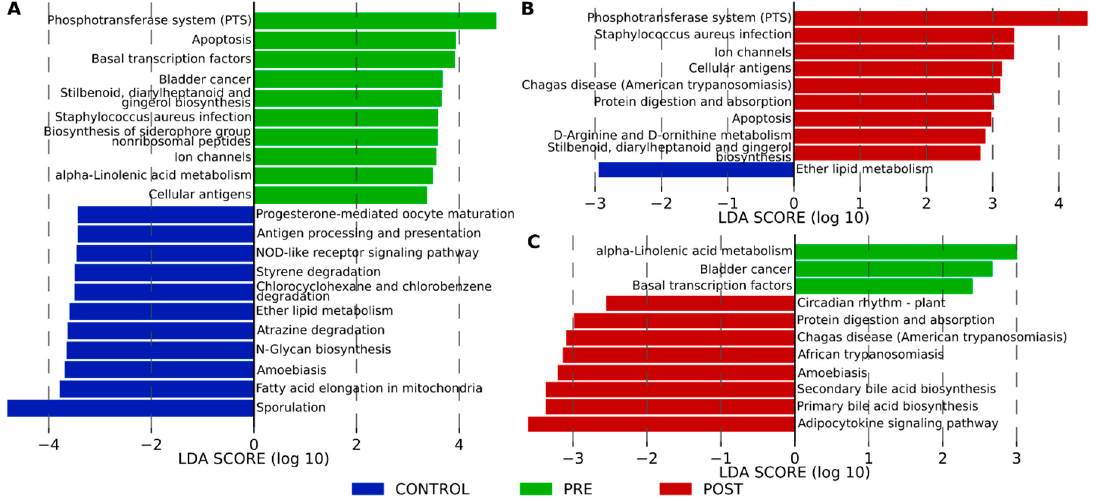
Figure 7. Functional divergence between the fecal microbiota of healthy controls and patients with CD pre- and post-IFX-therapy at the KEGG pathway level three. Comparison were performed between control vs CD pre-IFX-therapy ( A ), control vs CD post-IFX-therapy ( B ), and patients with CD pre- vs. post-IFX-therapy ( C ).